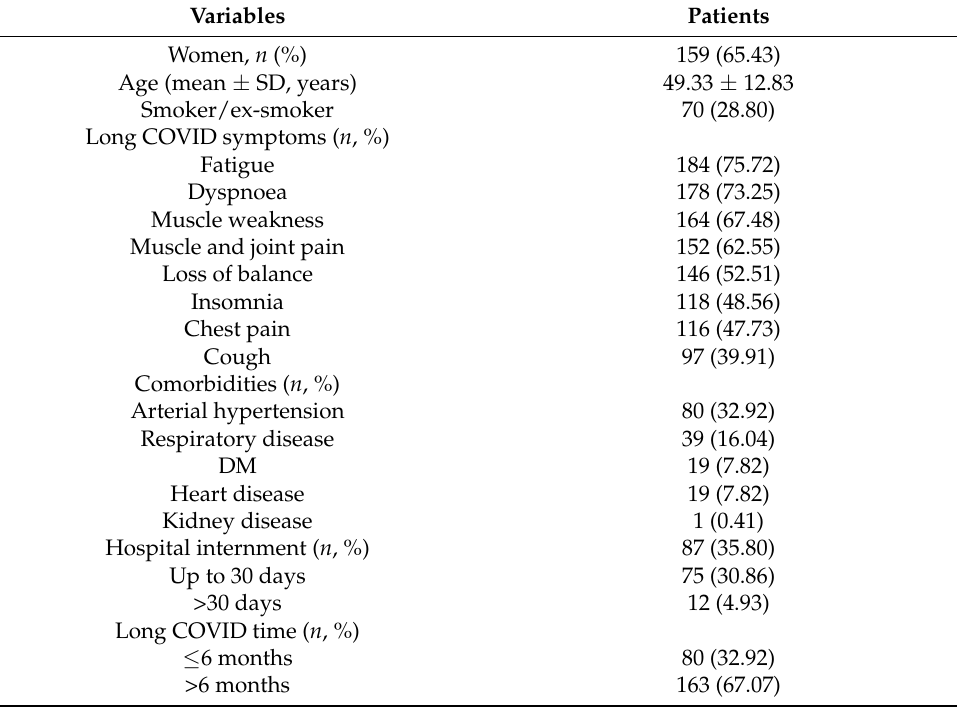
Table 1. Baseline data of the study patients. Bel é m/PA,